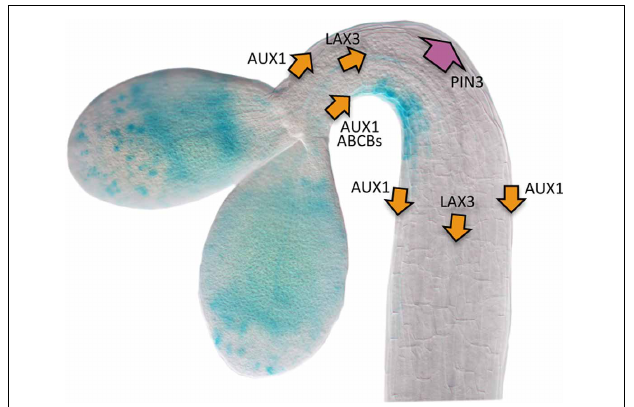
FIGURE 2 | Scheme of the transport machinery involved in the generation of the auxin gradient in the apical hook. The auxin flow directed by influx and efflux carriers is represented by orange and purple arrows, respectively. The wide arrow representing PIN3 activity means that this carrier performs a major role driving auxin toward the outer side of the hook. The image represents a DR5::GUS seedling during the formation phase. Picture courtesy of Dr. Javier